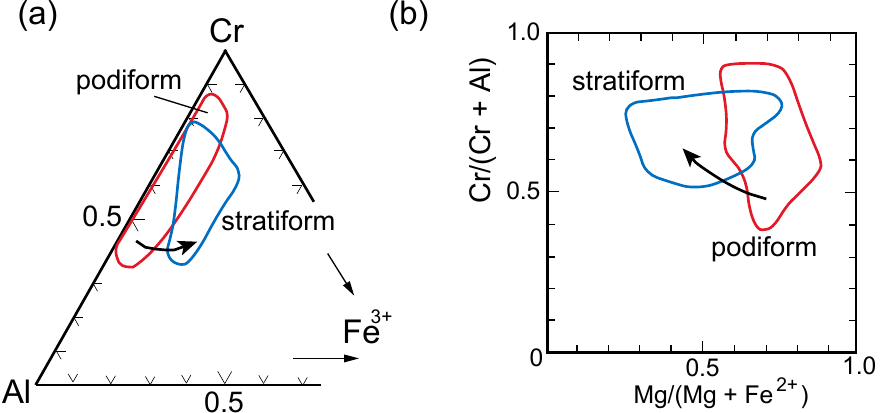
Figure 1. Chemical characteristics of chromites in stratiform and podiform chromitites. ( a ) The trivalent cation (Cr-Al-Fe 3+ ) ratios in an atom. ( b ) Relations between Mg/(Mg + Fe 2+ ) and Cr/(Cr + Al) in an atom. Data compilation by Arai and Miura [18] and Arai and Ahmed [20]. Arrows indicate possible modification of the chromite compositions during solidification of magmas in the crustal magma chamber in the model discussed below. See the text for more details.